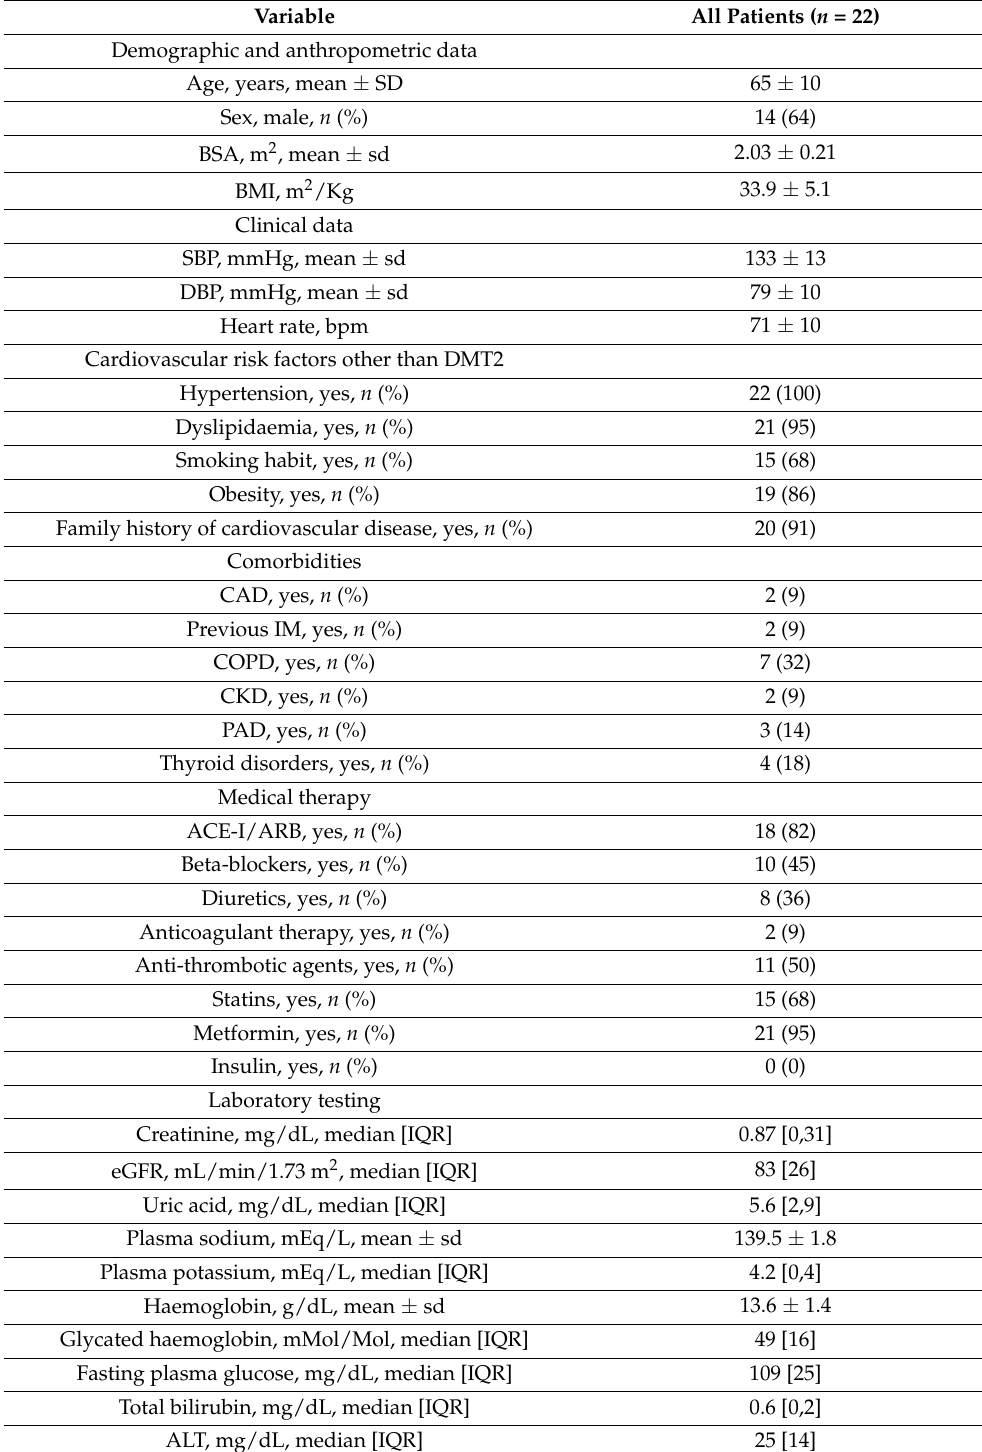
Table 1. Baseline characteristics of the study population. BSA: Body Surface Area; BMI: Body Mass Index; SBP: Systolic Blood Pressure; DBP: Diastolic Blood Pressure; CAD: Coronary Artery Disease; MI: Myocardial Infarction; COPD: Chronic Obstructive Pulmonary Disease; CKD: Chronic Kidney Disease; PAD: Peripheral Artery Disease; eGFR: estimated Glomerular Filtration Rate; ALT: Alanine-amino